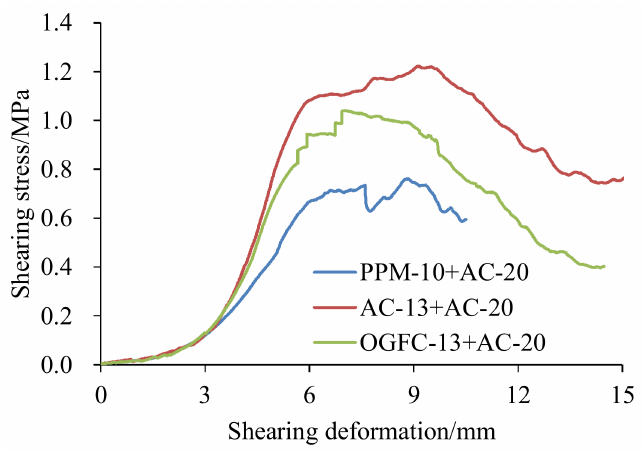
Figure 3. Shear stress-deformation curves of three composite specimens without adhesive materials.